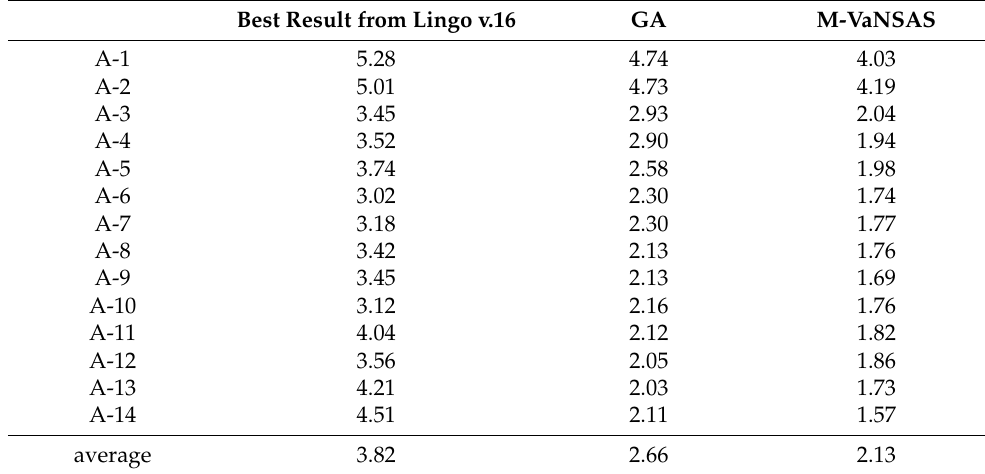
Table 12. Average cost per person of the population in the communities. Best Result from Lingo v.16